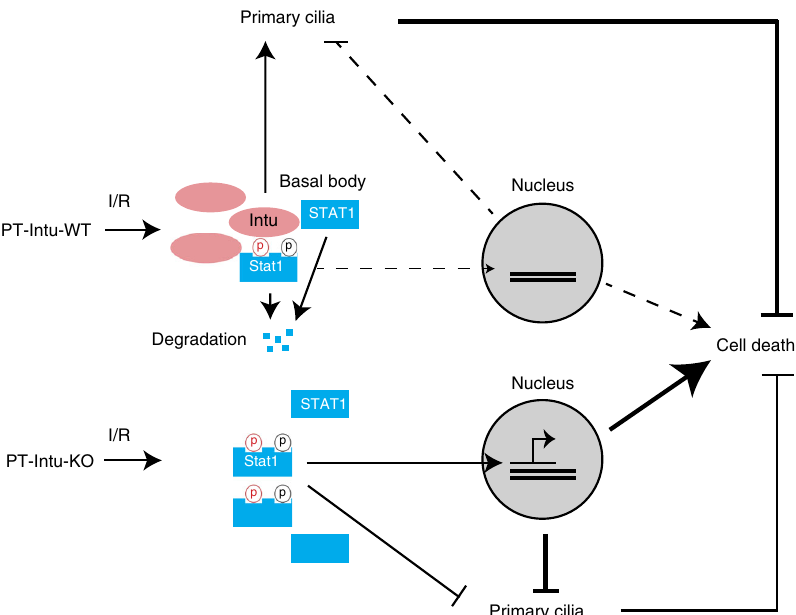
Fig. 8 Schematic model of Intu/STAT1 regulation of cell death and cilium in kidney injury. In wild-type cells and tissues, renal IRI upregulates Intu, which binds and sequesters STAT1 in the basal body/centriole area for degradation, reducing phosphorylated STAT1 translocation to the nucleus and alleviating cell death (upper). Intu-KO cells and tissues are devoid of Intu, the STAT1 antagonizing mechanism, and as a result, more phosphorylated STAT1 accumulates in the nucleus to promote cell death (lower). Also, Intu promotes ciliogenesis, whereas STAT1 may have opposite effects. Phosphorylated STAT1 is marked with a circled P in red for Y701 and in black for